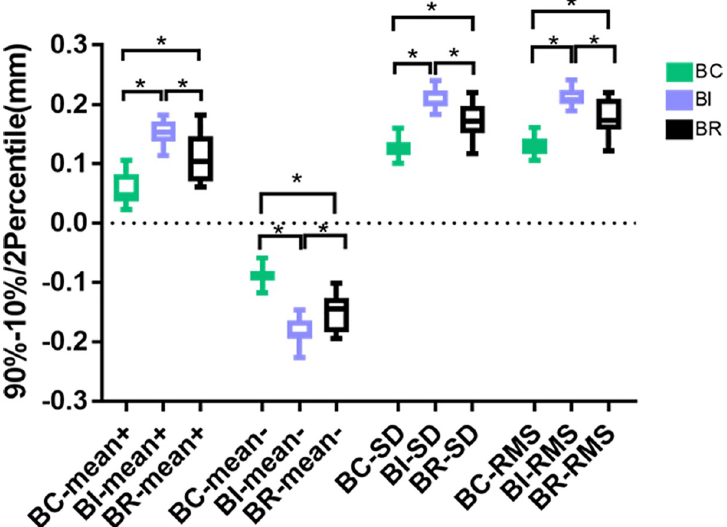
Fig 6. The average positive and negative deviations, standard deviations and RMS values between the auto- generated crown groups and the original tooth groups. � p <